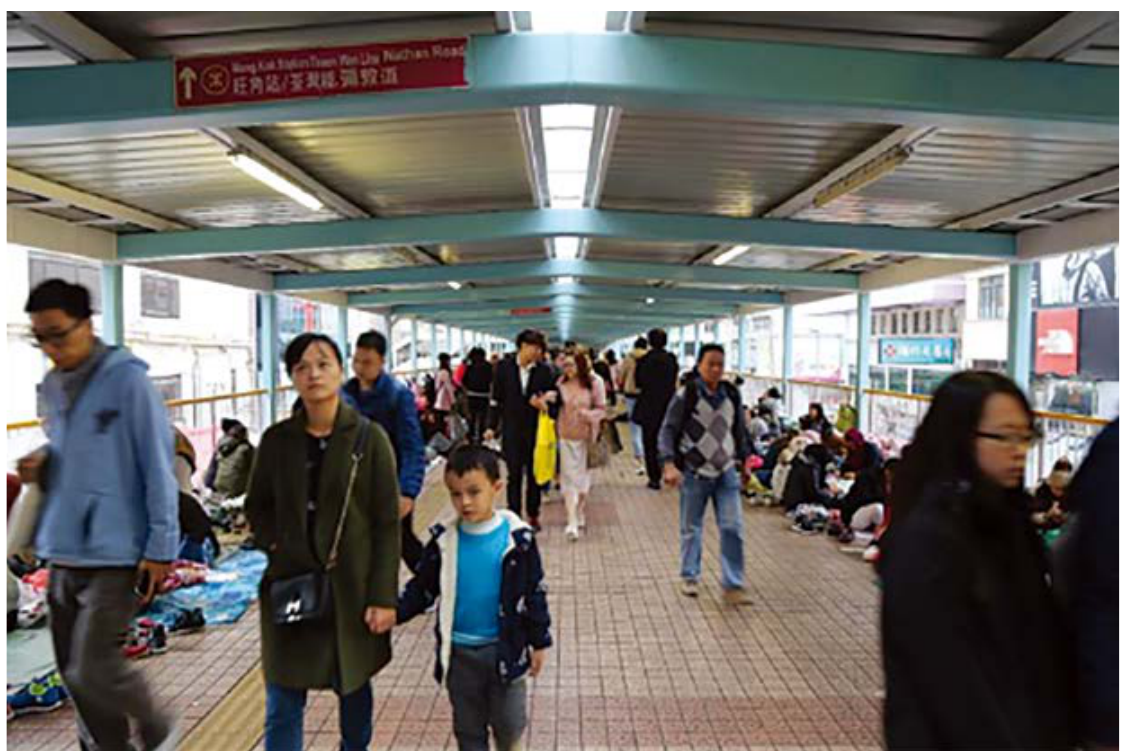
Figure 3: Pedestrian bridge, Mong Kok. Source: Tim Tang 2018. Figure 4 (opposite page): High as a vantage point, Kowloon Park. Source: Liao Jiaming